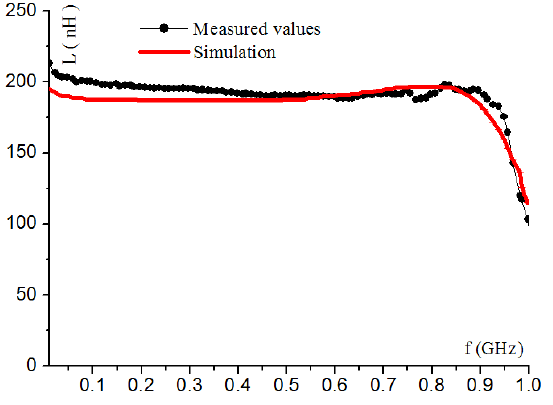
Figure 8: Evolution of the inductance versus frequency